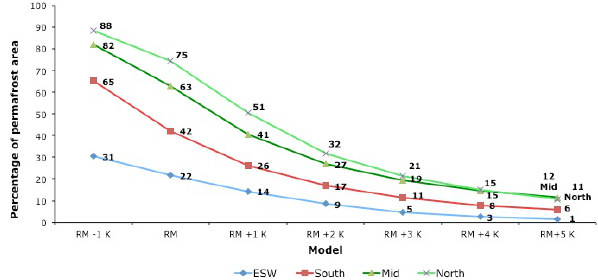
Fig. 9. Modelled percentage area underlain by permafrost under equilibrium conditions for each sub-region under the climate mod- elling